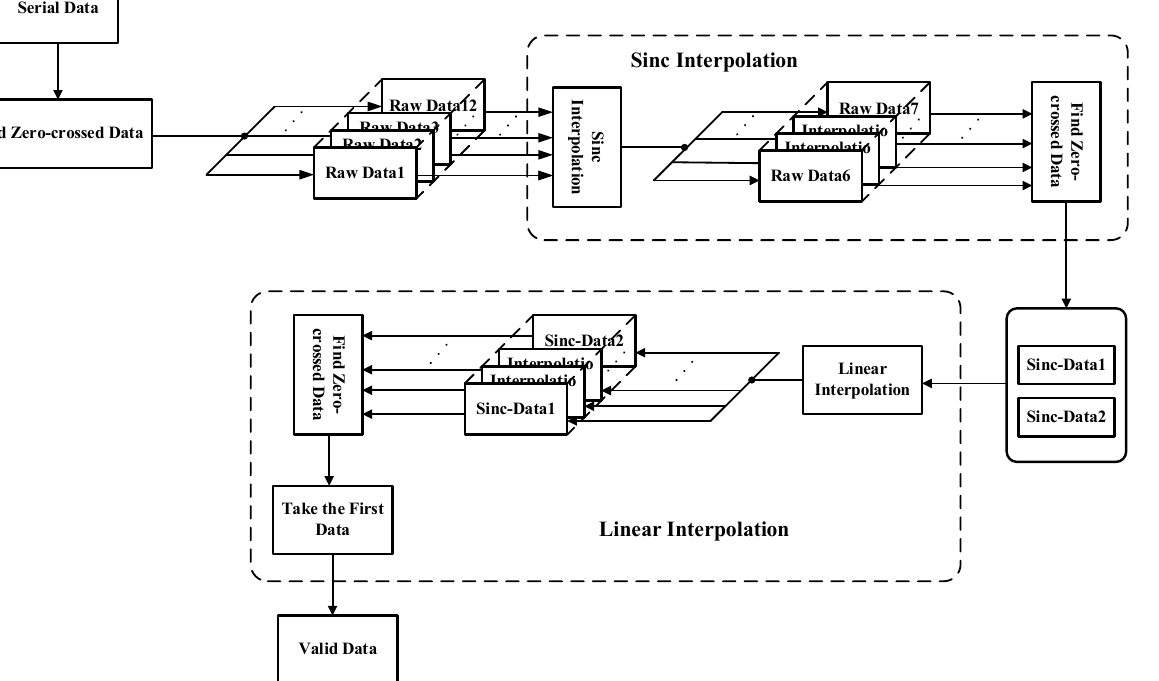
Figure 4. Schematic diagram of the combination of sinc interpolation and linear interpolation.